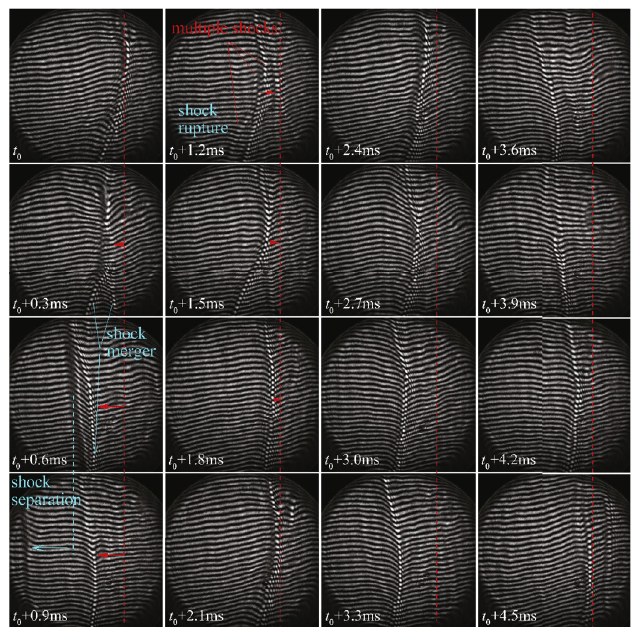
Figure 8: Mach-Zehnder images of the local shock from the vertical view ( Ma = 0 : 7 ).